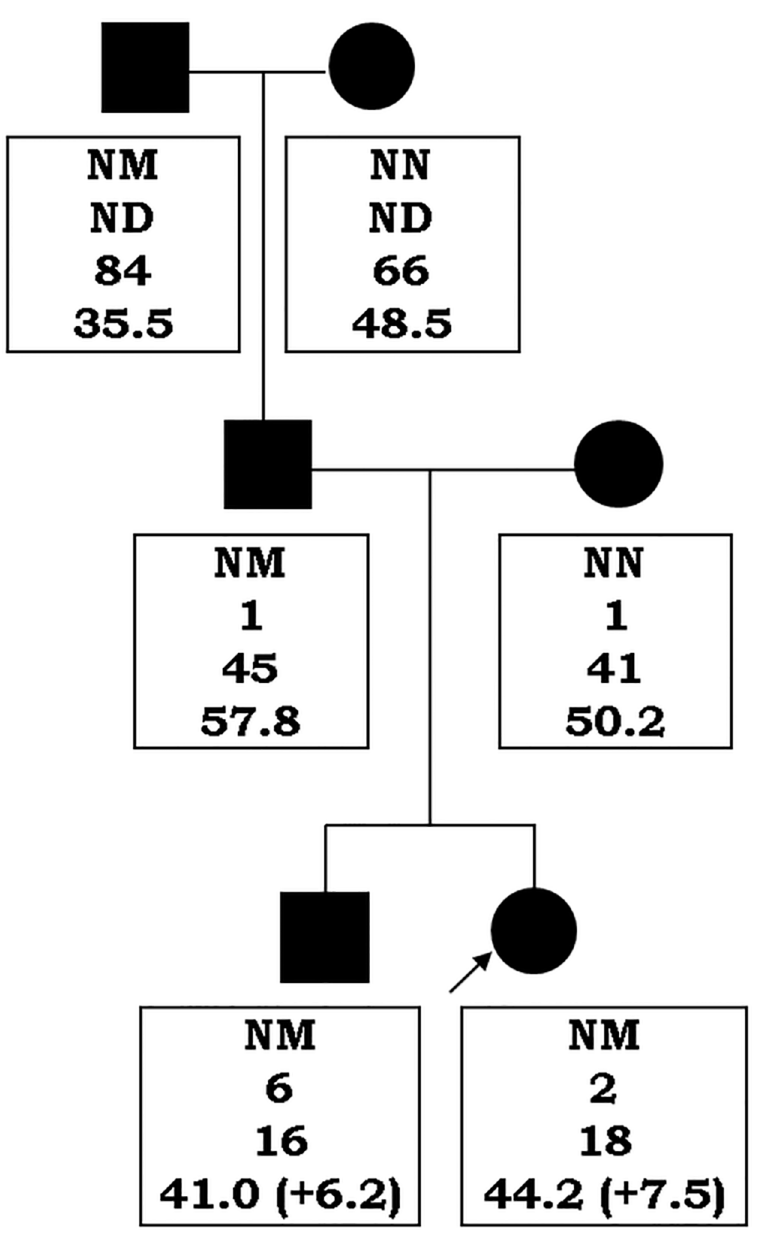
Fig 1. Pedigree of the family with the novel SIM1 variant p.D134N. Squares represent males; circles representfemales; filled symbols indicateobese individuals. Probandis indicatedby an arrow. The text below each individualindicatesmutational status (NM—heterozygous p.D134Ncarrier; NN—non-carrier), age at diagnosis of obesity, current age, and BMI (BMI SDS). ND—not determined.